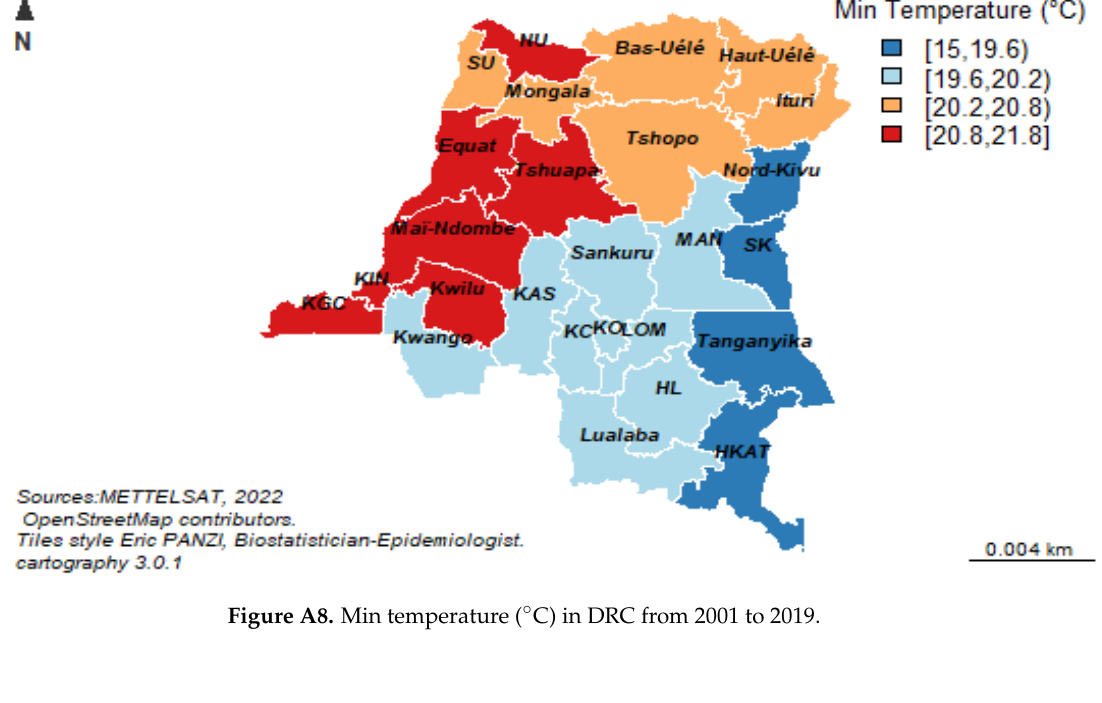
Figure A9. Total rainfall (mm) in DRC from 2001 to 2019.